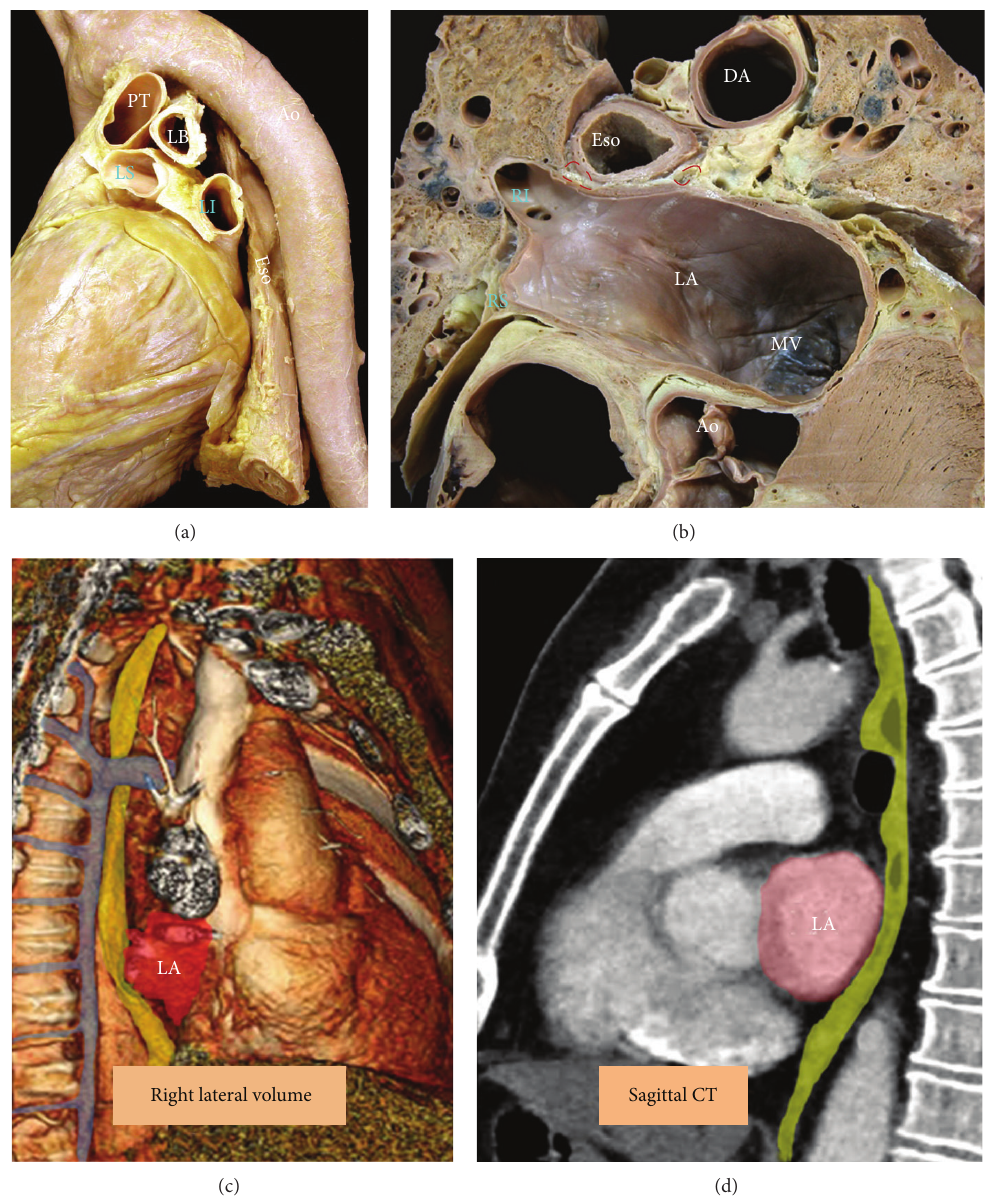
Figure 11: (a) Specimen viewed from a left posterolateral perspective to show the course of the esophagus (Eso) and descending aorta (DA) relative to the left atrium (LA). (b) An overview of a transthoracic section through a cadaver showing the locations of the esophagus, the descending aorta, and the vagus nerves (red dashed circles). Note the minimal distance between the endocardial surfaces of the right pulmonary vein. (c) Right lateral volume rendered CT angiography and (d) sagittal CT of chest show the relationship of the esophagus (yellow) to the left atrium (red). The azygos is shown in blue. LI = left inferior pulmonary vein, LS = left superior pulmonary vein, MV = mitral valve, PT = pulmonary trunk, Ao = aortic valve, LB = left bronchus, RI = right inferior pulmonary vein, and RS = right superior pulmonary